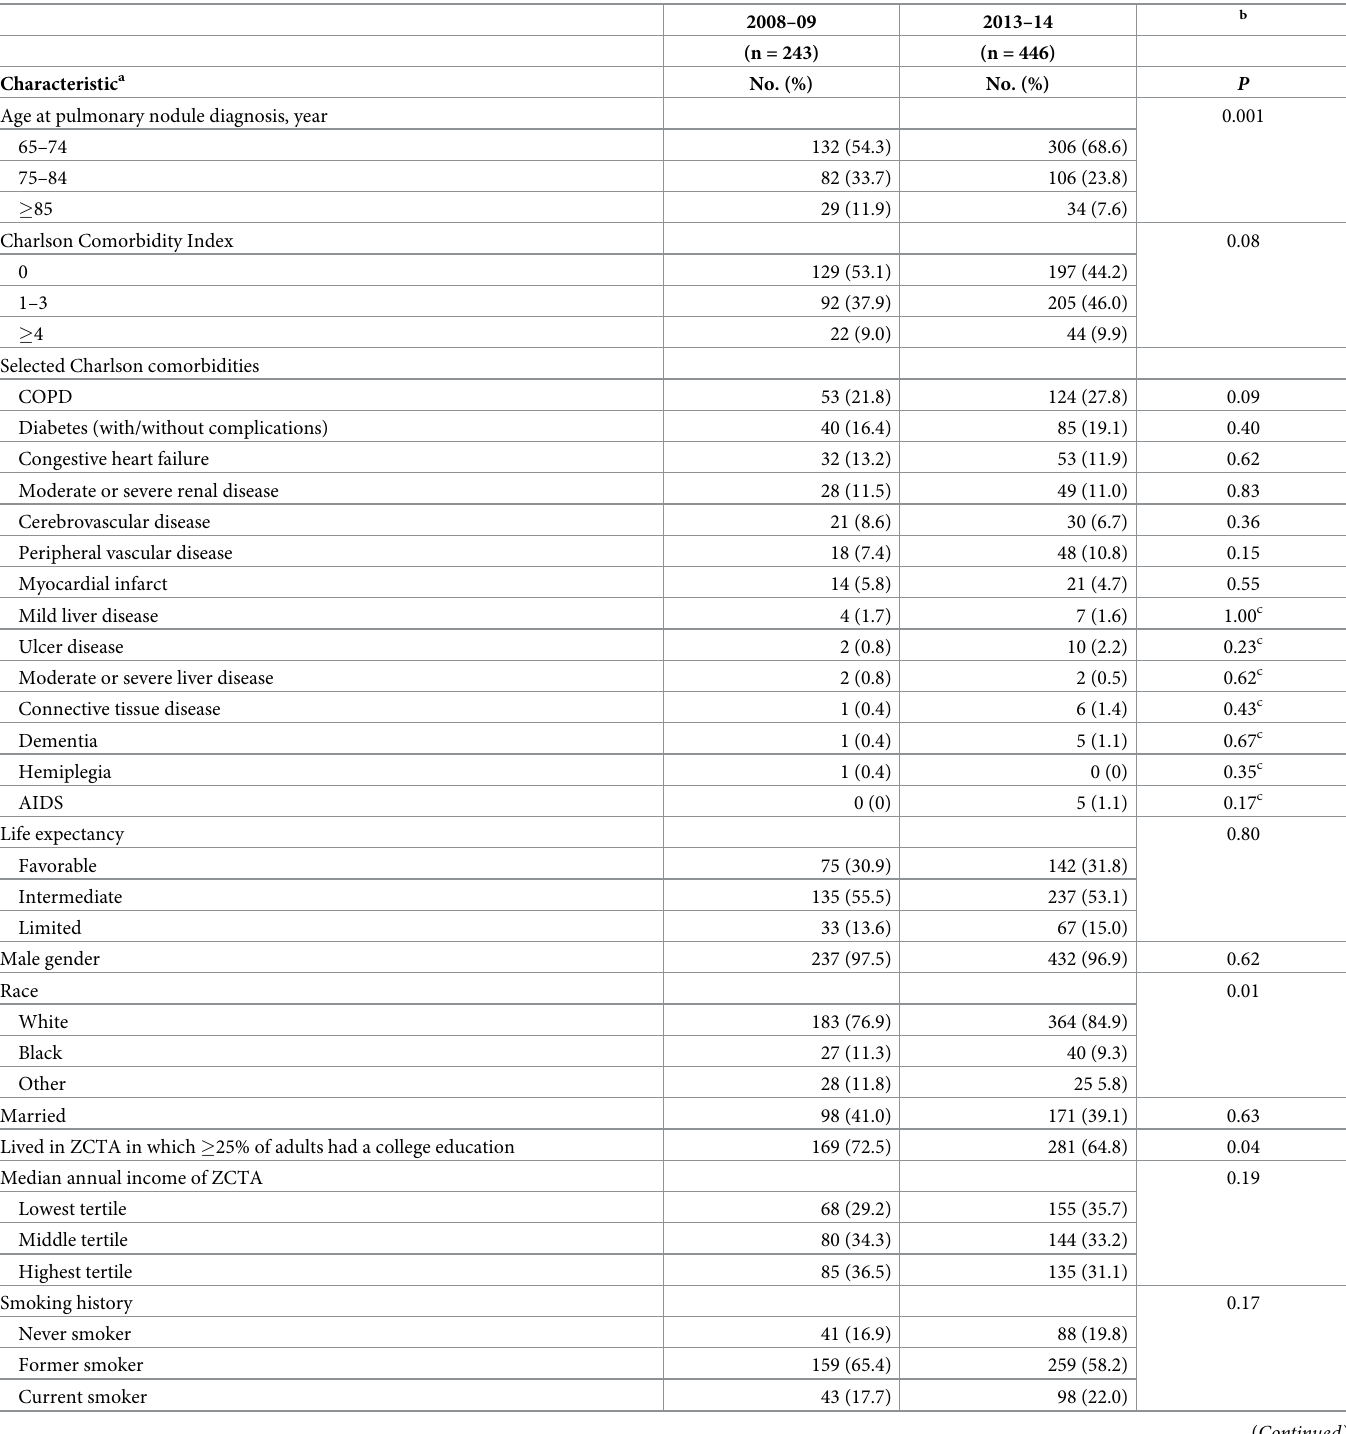
Table 1. Patient and baseline pulmonary nodule characteristics in veterans age (cid:21) 65 with newly diagnosed pulmonary nodule(s) by diagnosis year group (N =